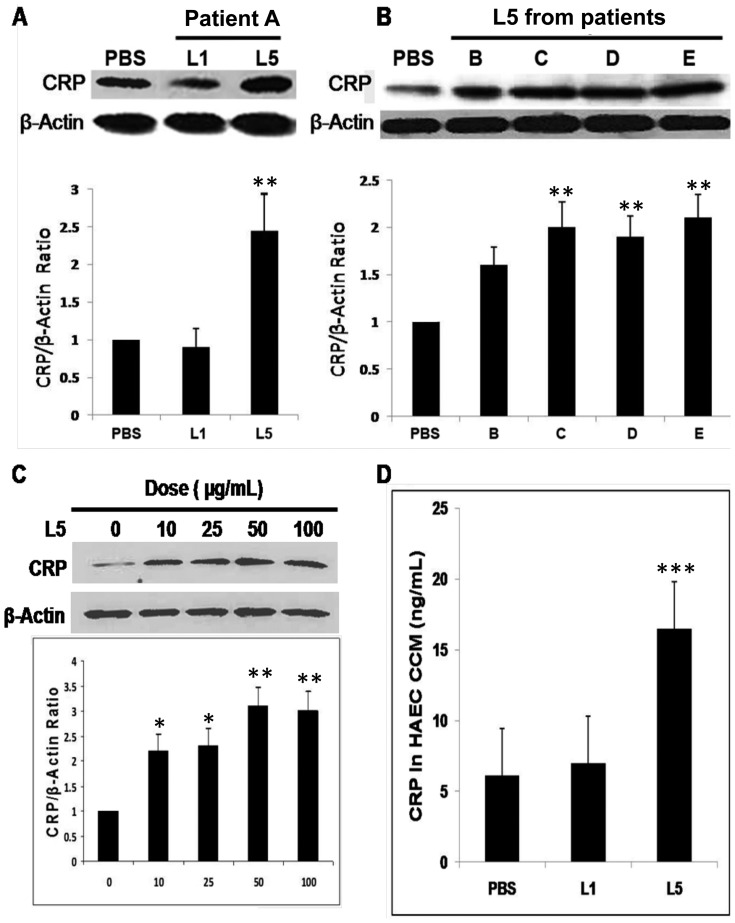
Analysis of C-reactive protein (CRP) expression by using Western blot and enzyme-linked immunosorbent assay (ELISA).(A, B) C-reactive protein expression in human aortic endothelial cells (HAECs) treated with L5 from 5 hypercholesterolemic patients (patients labeled as A–E). L5 increased endothelial CRP expression by up to 2.5-fold more than did L1. (C) L5 treatment (10–100 µg/mL) increased endothelial CRP expression in a dose-dependent manner. (D) ELISA analysis of CRP in the conditioned culture medium (CCM) of HAECs treated with phosphate-buffered saline (PBS), L1, or L5. For all experiments, n = 3, and bars shown in graphs represent standard deviation. *P<0.05, **P<0.01, ***P<0.001 vs. PBS or untreated control.